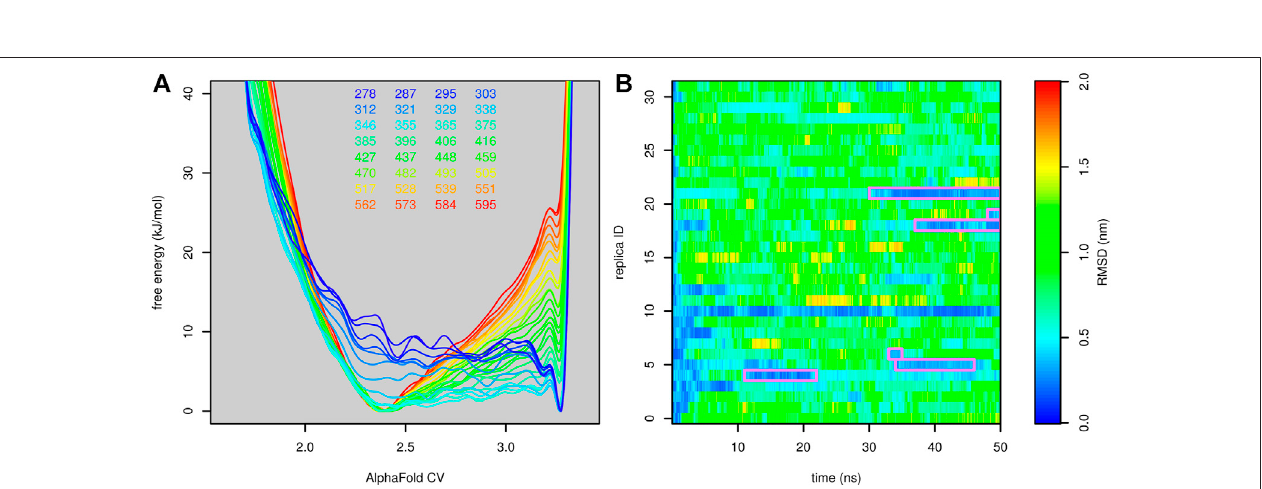
Frontiers in Molecular Biosciences |